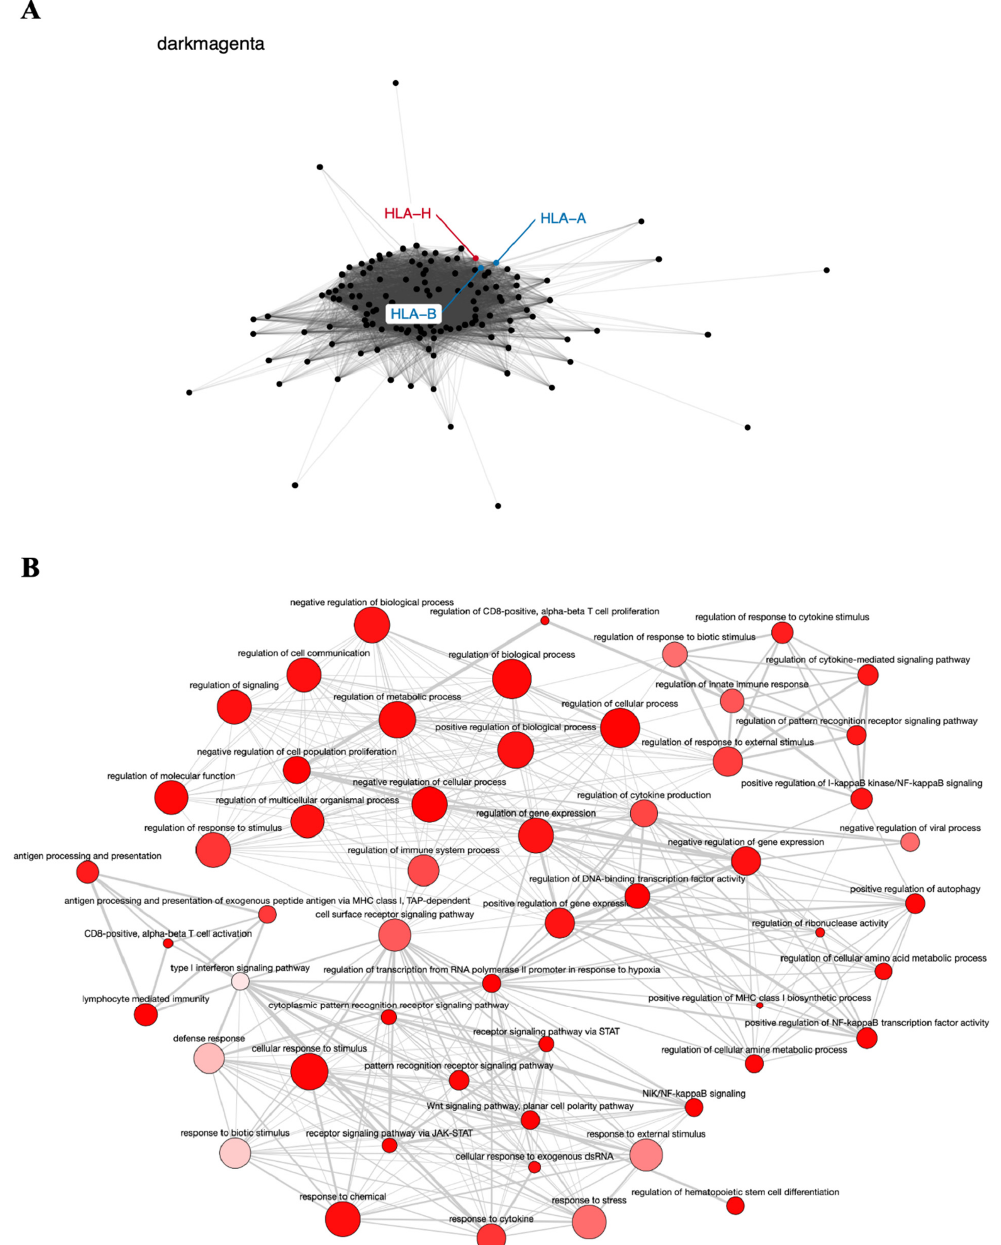
Figure 4. Co-expression network and GO enrichment analysis. Dark magenta module containing HLA-H pseudogene from co-expression network of 213 head and neck cancer (HNC) patients and gene ontology (GO) enrichment analysis. ( A ) Network highlighting pseudogene (red letter) and HNC-related genes (blue letter) constructed using the Weighted Correlation Network Analysis (WGCNA) R software package. ( B ) Enriched GO terms identified by GOATOOLS Python library and summarized by the web tool REVIGO. Circles colored with darker red indicate GO terms with lower p -values in our enrichment analysis, while the size of the circles indicates the frequency of a GO term in the GO annotation database. GO terms that are highly similar have thicker